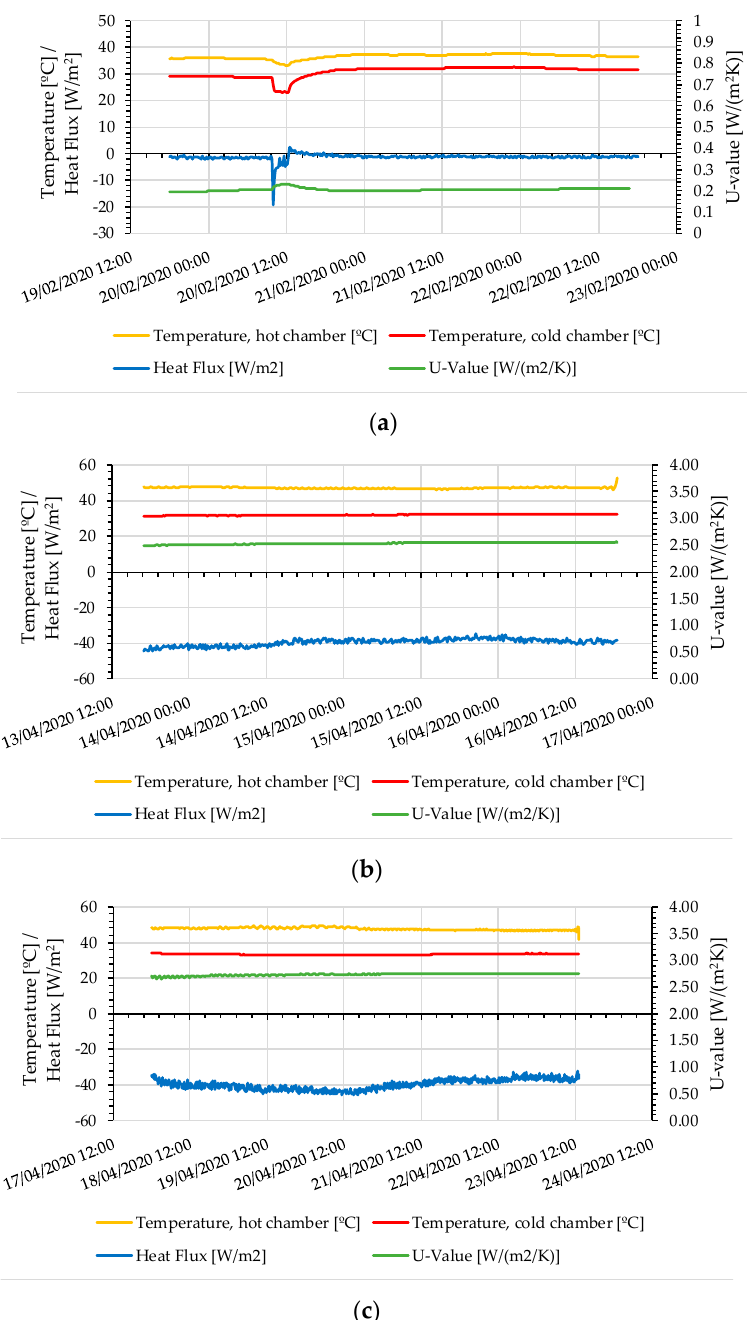
Figure 17. Measurements of the heat flux, hot and cold superficial temperatures and U-value in the XPS wall ( a ) and in the small CEBs wall ( b , c ).